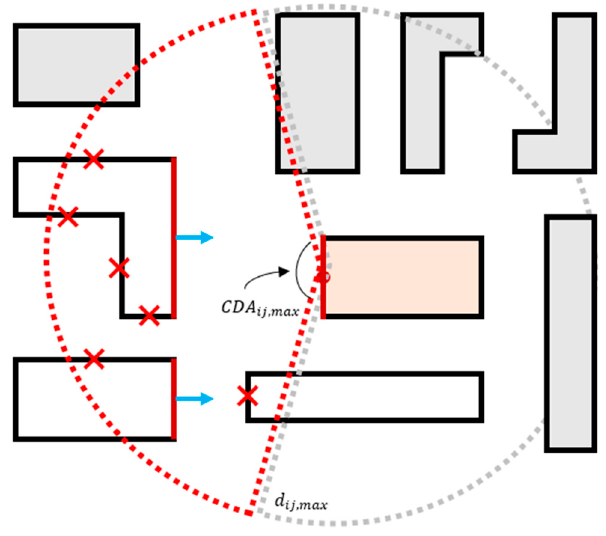
Figure 2. Simplified scheme of the calculation of mutual shading factor. The red line on the central building is the surface for which the calculation is per- formed. The dashed circle represents the distance tolerance, while the red zone of the circle shows the second check on the centroids direction angle. Red lines on white buildings represent the surfaces that face and can shade the surface under calculation, while the surfaces marked with a cross represent those that do not respect the third check regarding the mutual orientation angle. Blue arrows indicate the normal direction of the shading surfaces. height and the limit azimuth angles are calculated for each couple of surfaces. The